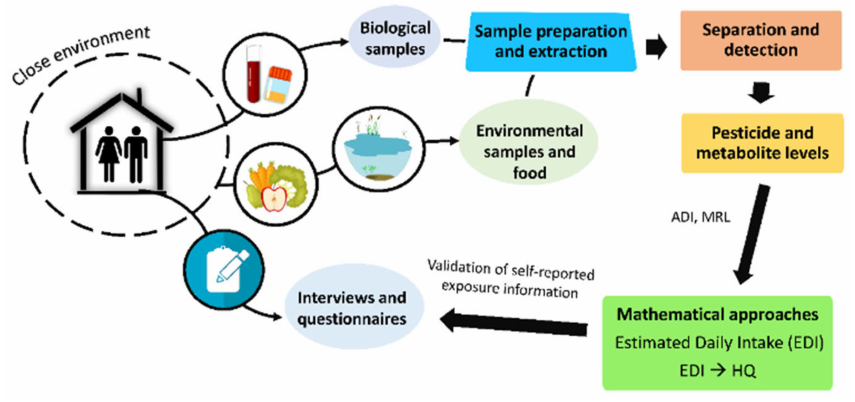
Figure 2. Main steps involved in a comprehensive assessment of human exposure to